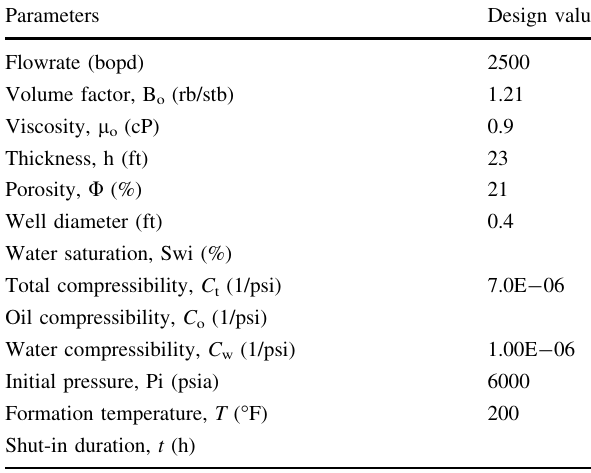
Table 1 Reservoir and fluid data (Windowstm Application